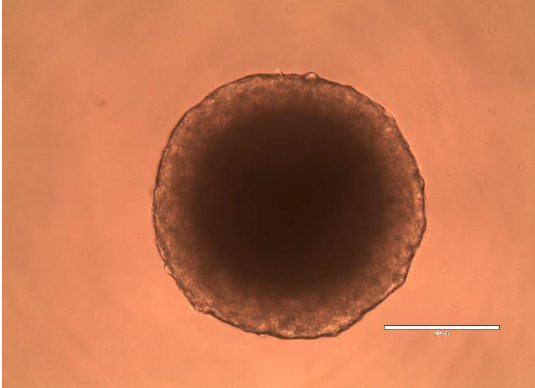
Figure 1. Photomicrograph of an experimental tumor nodule (tumor